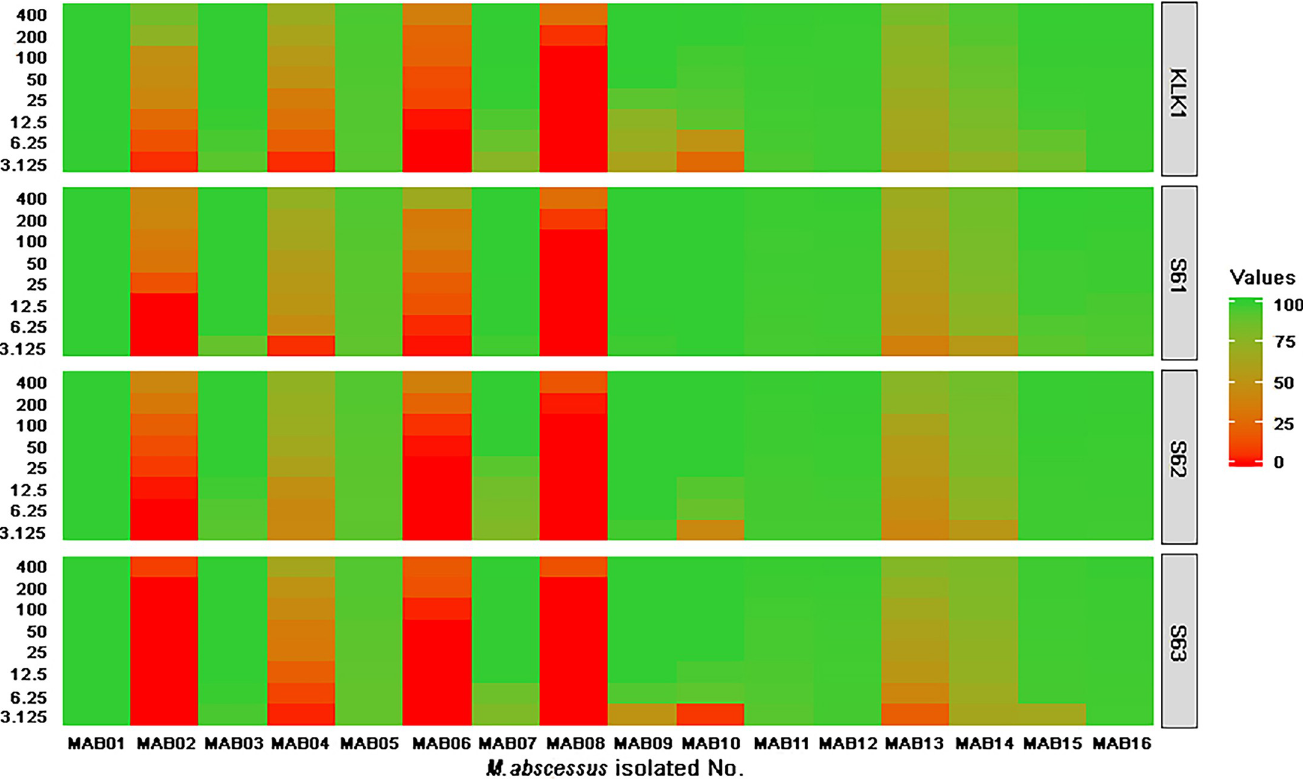
Fig 1. The 24-hour bactericidal activities of four AMPs against sixteen clinical isolates of M . abscessus . The heat map demonstrates the percentages of killing of four AMPs against each of the M . abscessus isolates. The green color represents high bactericidal activity (100% killing score) and the red indicates low bactericidal activity (0% killing